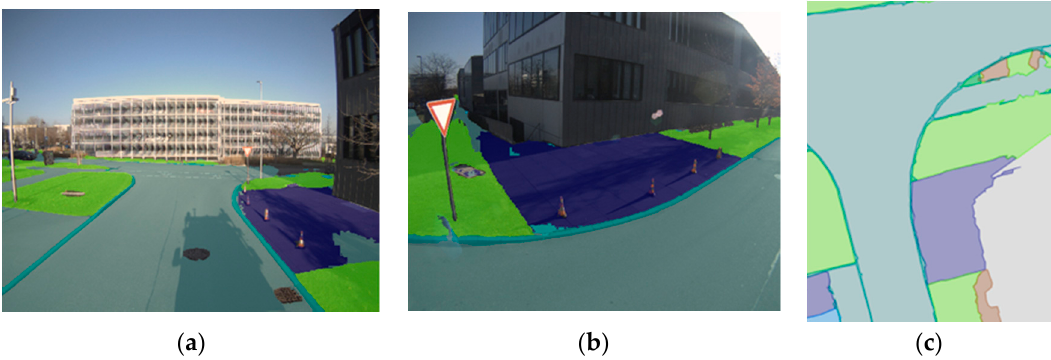
Figure 9. Classification of the same paved surface on an image taken by the front and tight camera. (a) Segmentation on the image taken with the front camera contains a spot, where the paved surface is misclassified as asphalt (grey); (b) in the image taken with a full view of the surface, it is correctly classified as large paving (dark blue); (c) correct polygon output.